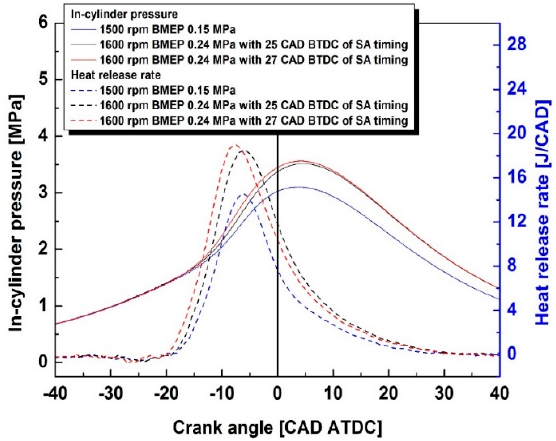
Figure 3. In-cylinder pressure traces and heat release rates for 1500 rpm with BMEP of 0.15 MPa and 25 CAD BTDC of SA timing for 1600 rpm and BMEP of 0.24 MPa; and 25 and 27 CAD BTDC of SA timings.